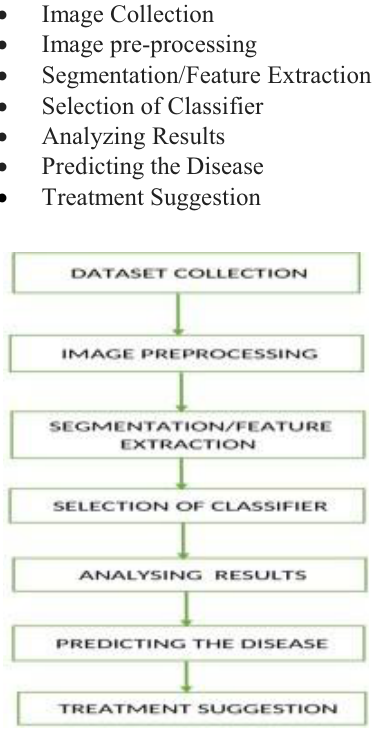
Fig 2. Workflow of the